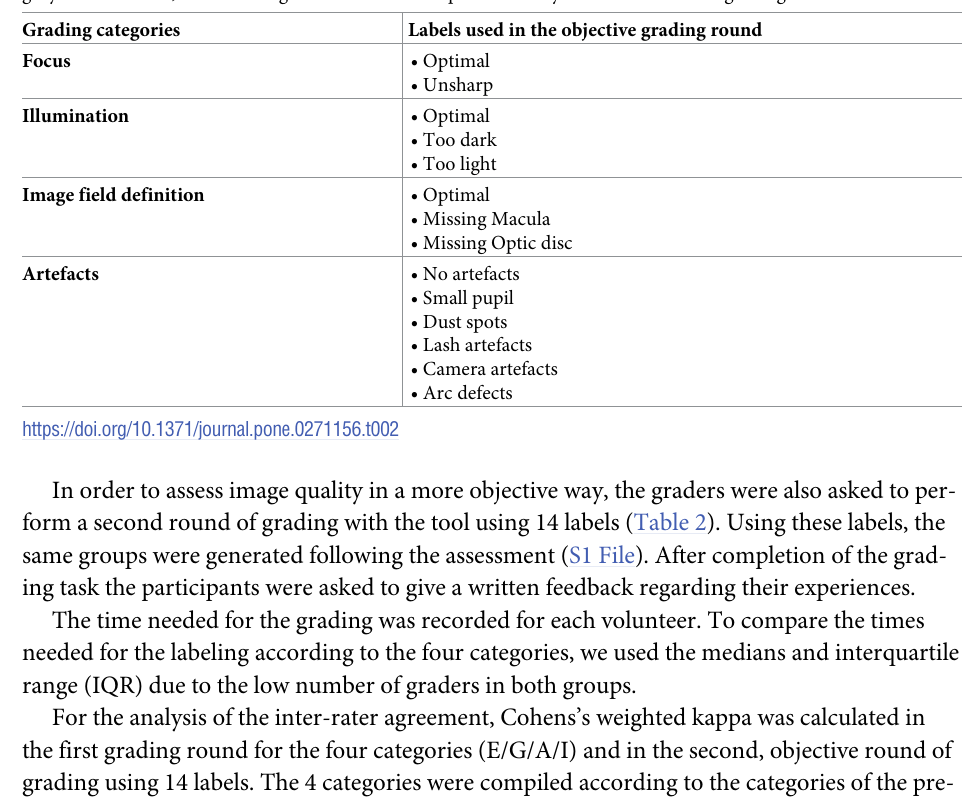
Table 2. Grading labels used for the objective grading round. In order to decrease the inherent subjectivity of our study, our participants were asked to perform a second round of grading using predefined labels assigned to each cate- gory. In this round, the four categories were then complied similarly to the first round of grading.